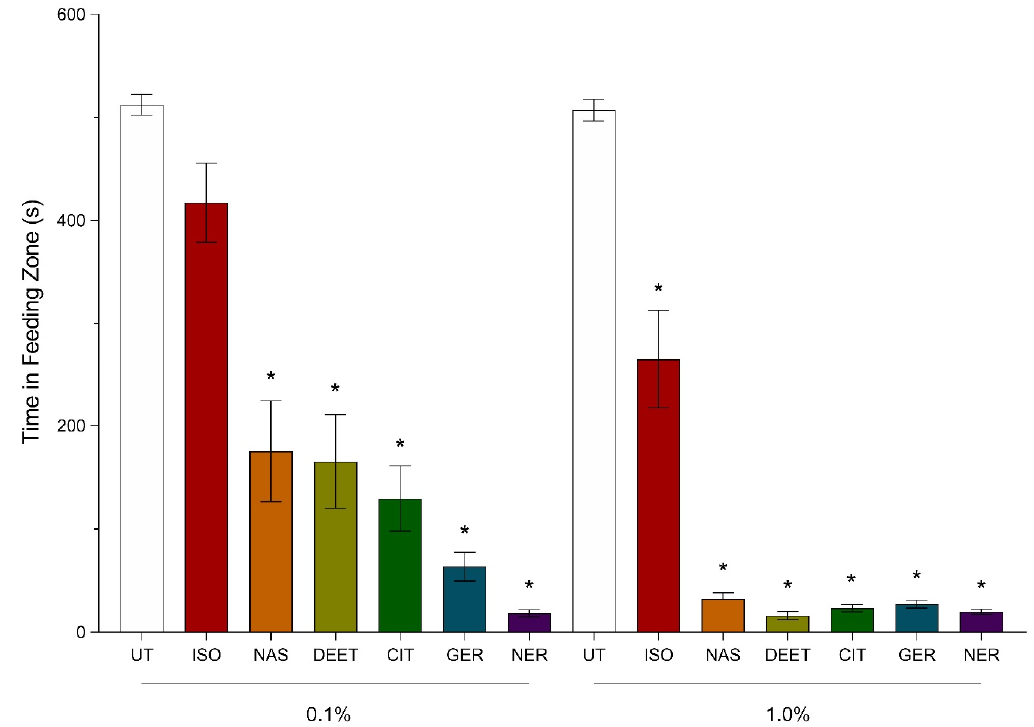
Figure 2. Efficacy of Nasonov terpenoids and N,N -diethyl-meta-toluamide (DEET) at 0.1 and 1.0% ( v / v ). Untreated (UT), isoamyl acetate (ISO), synthetic Nasonov pheromone (NAS), citral (CIT), geraniol, (GER), and nerol (NER). A video tracking protocol with individual bees in Petri dishes was used to observe behavior changes when exposed to sugar–agarose cubes treated with the terpenoids. The UT controls were sugar–agarose cubes with no terpenoid or DEET treatment. The DEET treated sugar–agarose cubes were screened as a positive control. Vertical bars represent mean ± standard error. Asterisks above the bars indicate a significant difference between the mean of the terpenoid- or DEET-treated bees compared to the UT bees using a one-way ANOVA with a Tukey’s post-hoc test ( p < 0.0001).